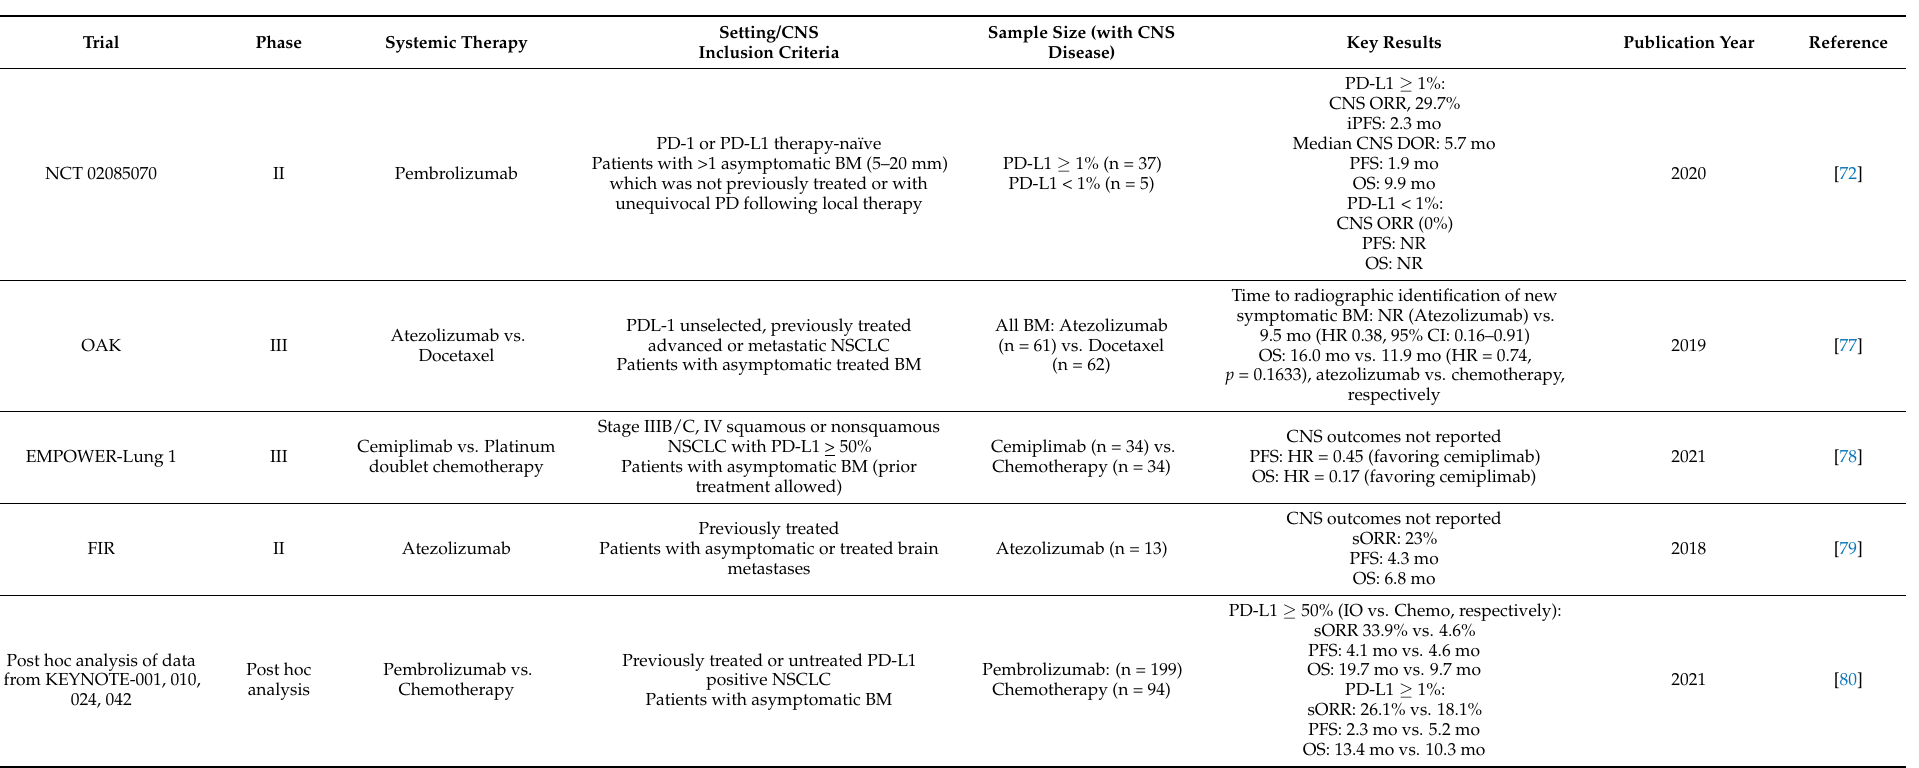
Table 2. Efficacy of Immune Checkpoint Inhibitor (ICI) Monotherapy in Non-small Cell Lung Cancer (NSCLC) with Central Nervous System (CNS)